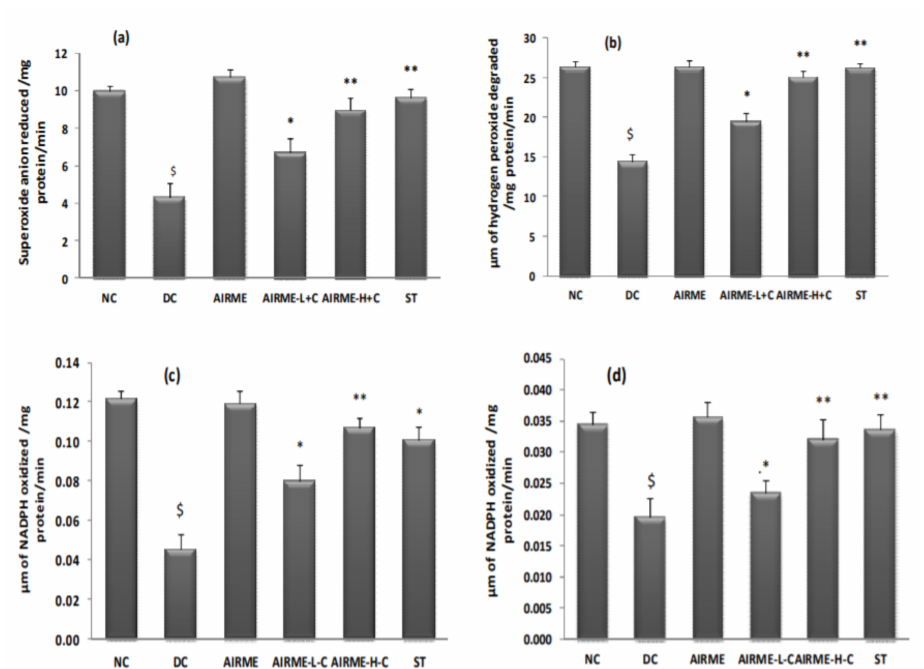
Figure 3. Changes in antioxidant enzyme (superoxide dismutase ( a ), catalase ( b ), glutathione reductase ( c ), glutathione peroxidase ( d )) activities in paw tissues of different groups of rats. NC, normal control; DC, disease control (carrageenan); AIRME, Acalypha indica root methanolic extract; AIRME-L+C (AIRME low dose plus carrageenan); AIRME-H+C (AIRME high dose plus carrageenan), and ST (standard treatment, diclofenac). All values represented as mean ± SD ( n = 6). $ indicates significant ( p < 0.05) difference with NC. * ( p < 0.05) and ** ( p < 0.01) indicates significant difference with